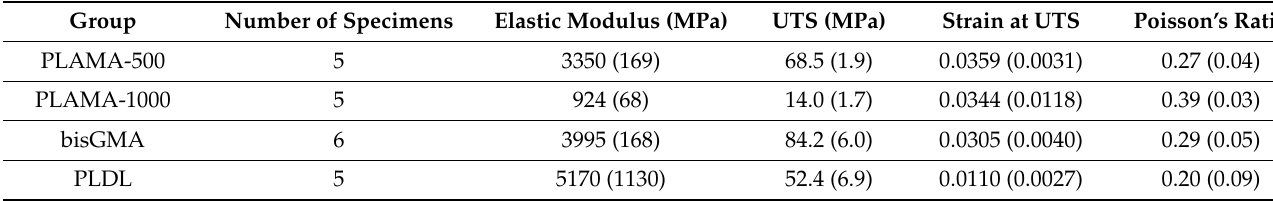
Table 3. Numerical results of the tensile test.